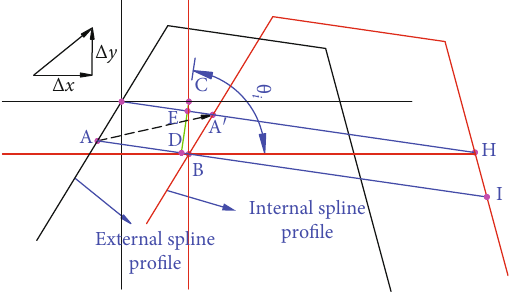
Figure 8: Graphic of L ed (considering the external spline as an example, where point A and point A ′ are the positions of the engagement points on the external spline before and after the movement). Table 1: vibration parameters of involute spline coupling. The parameters The value